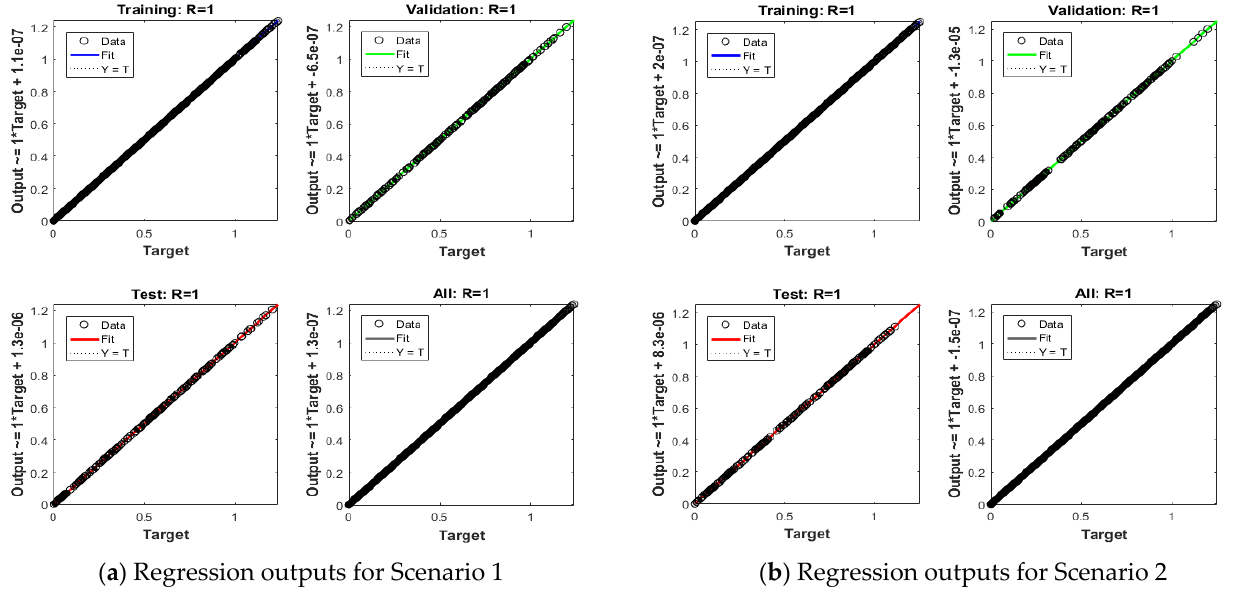
Figure 10 : Regression performance of the proposed TLMB-NN for solving HTM-BFN model with MHD of Scenarios 1 and 2.